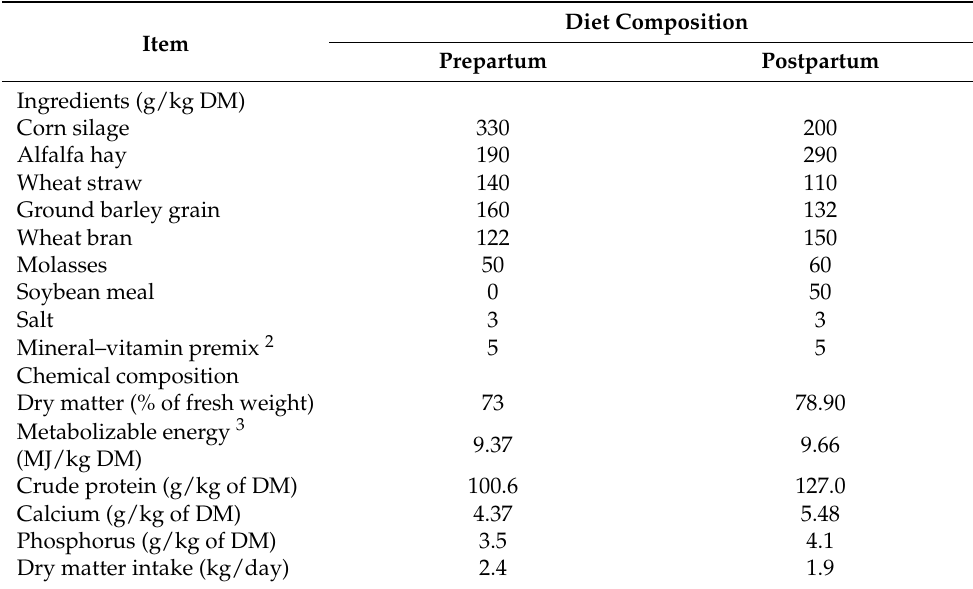
Table 1. Formulation and chemical composition of the basal diet 1 . Same data as reported in